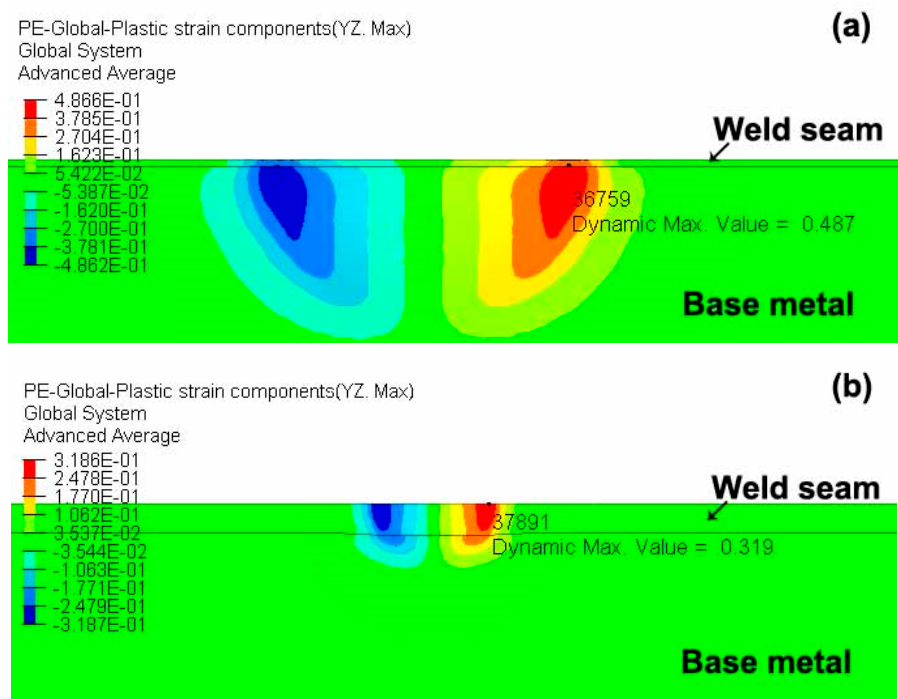
Figure 12. Strain distribution of welded joints of ( a ) 0.5 mm HZ and ( b ) 8.5 mm HZ during the cupping test.